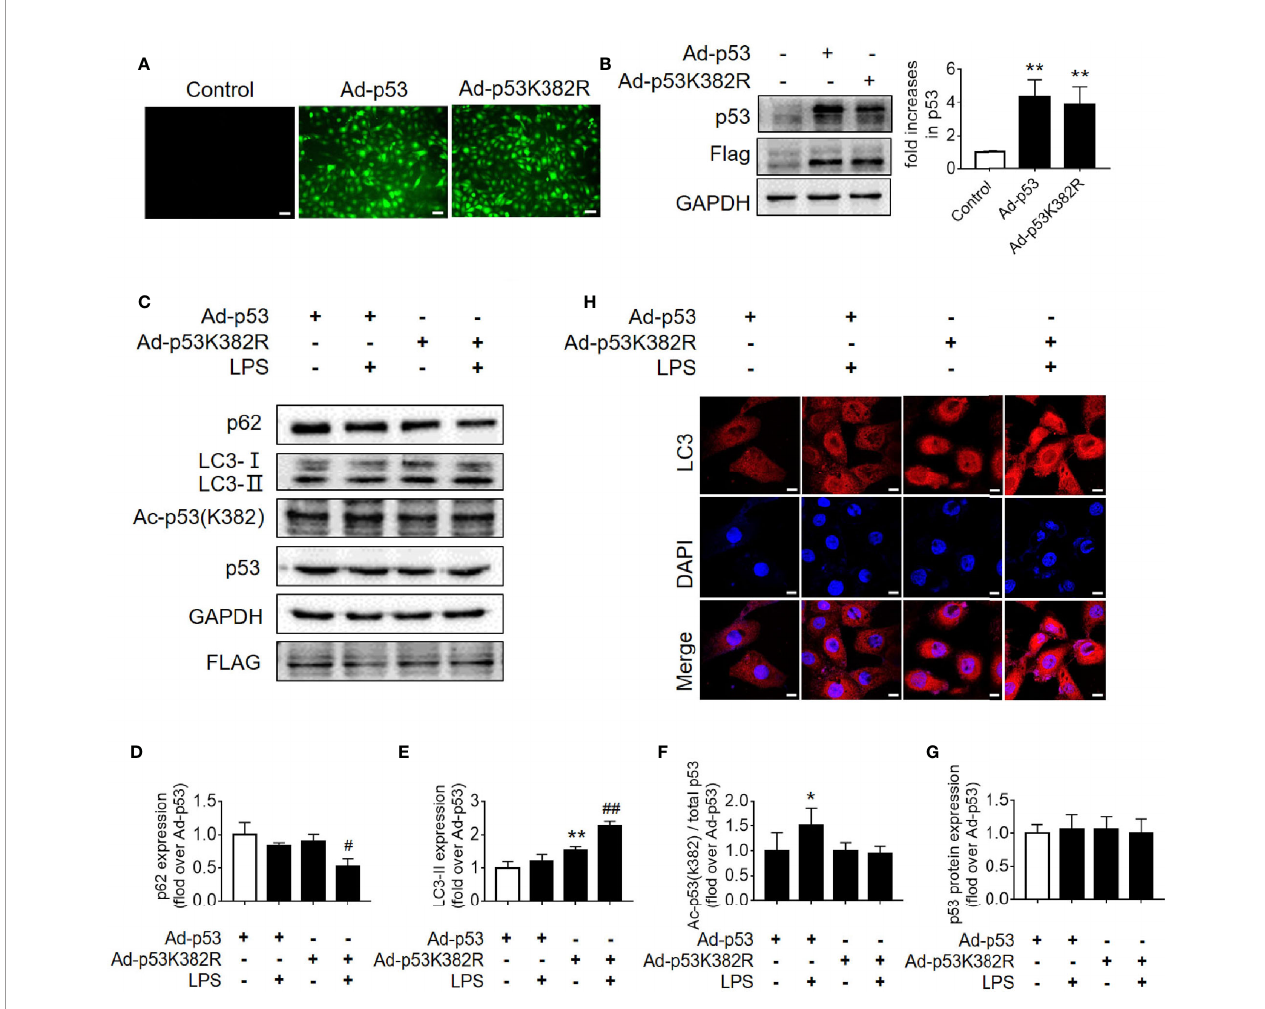
FIGURE 6 | Mutation of p53 (K382 lysine site) mediated-p53 deacetylation promotes autophagy. (A) Con fi rmation of the effect of p53 virus transfection. HK-2 cells were transfected with either p53 adenovirus (Ad-p53) or p53K382R adenovirus (Ad-p53K382R). Deacetylation of p53 was induced by the mutation of lysine (K) at 382 to arginine (R). (B) Representative western blot and densitometric analyses of p53 protein expression. n = 3. ** p < 0.01 vs. Control group. (C) Representative western blot of p62, LC3-I, LC3-II, acetylated p53 (Ac-p53), and p53. GAPDH was used as an internal reference. (D – G) Densitometric analyses of p62, LC3-I, LC3- II, acetylated p53 (Ac-p53), and p53. n = 3-4. * p < 0.05, ** p < 0.01 vs. the Ad-p53 group; # p < 0.05, ## p < 0.01 vs. the Ad-p53 + LPS group. (H) Effects of the p53 point mutation on autophagy protein LC3 under cellular immuno fl uorescence (magni fi cation ×630 and scale bar = 10 µm). LC3 is labeled with red fl uorescence of GRF, and the nucleus is labeled with the blue fl uorescence of DAPI. The brightness of red represents the abundance of LC3 protein. LC3II, Microtubule-associated protein 1A/1B-light chain 3; GAPDH, glyceraldehyde 3-phosphate dehydrogenase; LPS, lipopolysaccharide; DAPI, 4 ’ ,